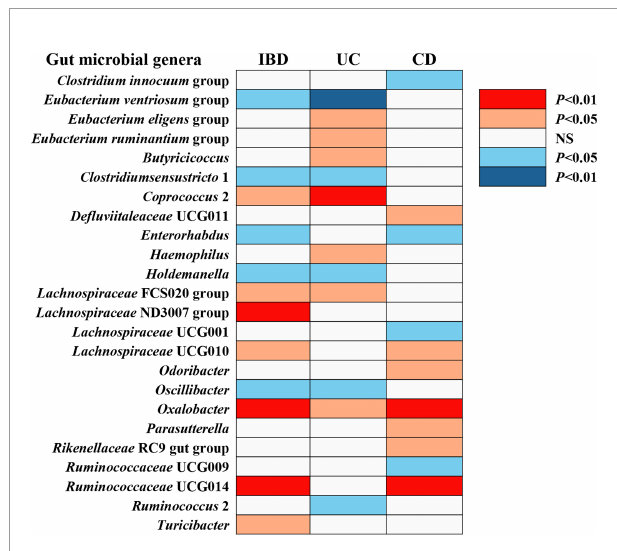
FIGURE 2 | The causal effect of gut microbial genera on IBD, UC, and CD identi fi ed at the nominal signi fi cance ( P < 0.05/0.01). Shown are the results derived from the IVW method. Red represents the risk genera for IBD, blue represents the protective genera for IBD, and white represents no causal genera for IBD. Abbreviations: CD, Crohn ’ s disease; IBD, in fl ammatory bowel disease; UC, ulcerative colitis; NS, no signi fi cant association.